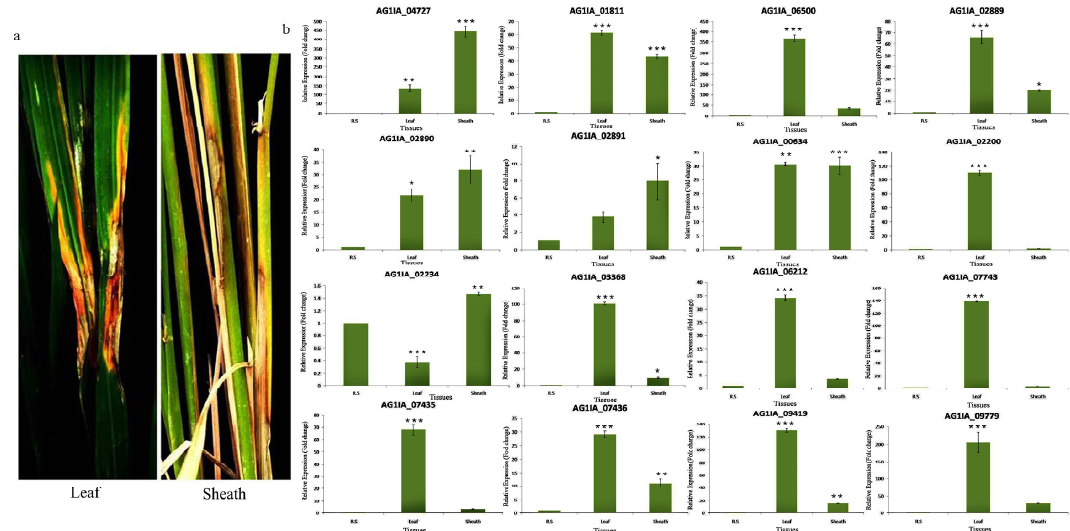
Figure 8. ( a ) The sheath blight disease symptoms on the leaf blade and sheath tissues of TN1 upon inoculation of R. solani Wgl-2. ( b ) qRT-PCR expression analysis of 16 PD genes (polygalacturonases and pectinesterases) in leaf blade and sheath tissues after R. solani inoculation. X-axis: samples ( R. solani inoculated leaf blade and sheath tissues of TN1); Y-axis: Expression level of the individual PD genes relative to their expression in R. solani grown in PDA. Error bars indicate the mean ± S.E. of three biological replicates. Statistical significance was determined by performing one-way ANOVA analyses followed by a Tukey’s test (* = p < 0.01, ** = p < 0.001, and *** = p < 0.0001).